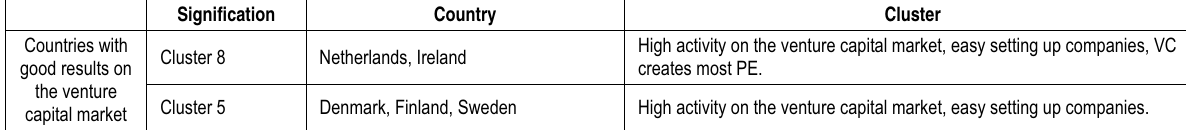
Table 1. Typology of EU countries according to the situation on the venture capital